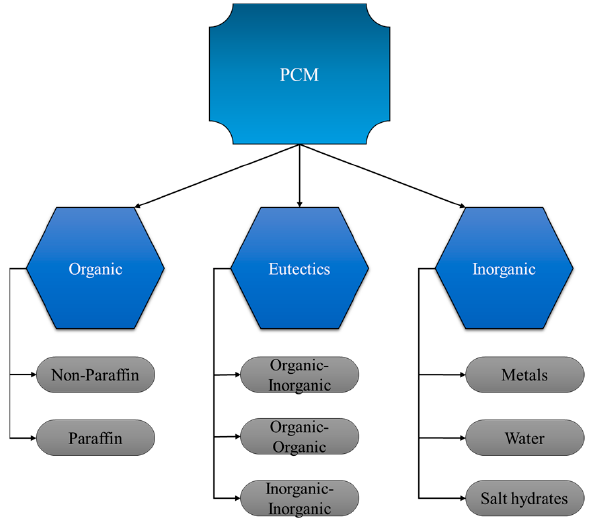
Figure 2. Classi fi cation of the PCM.